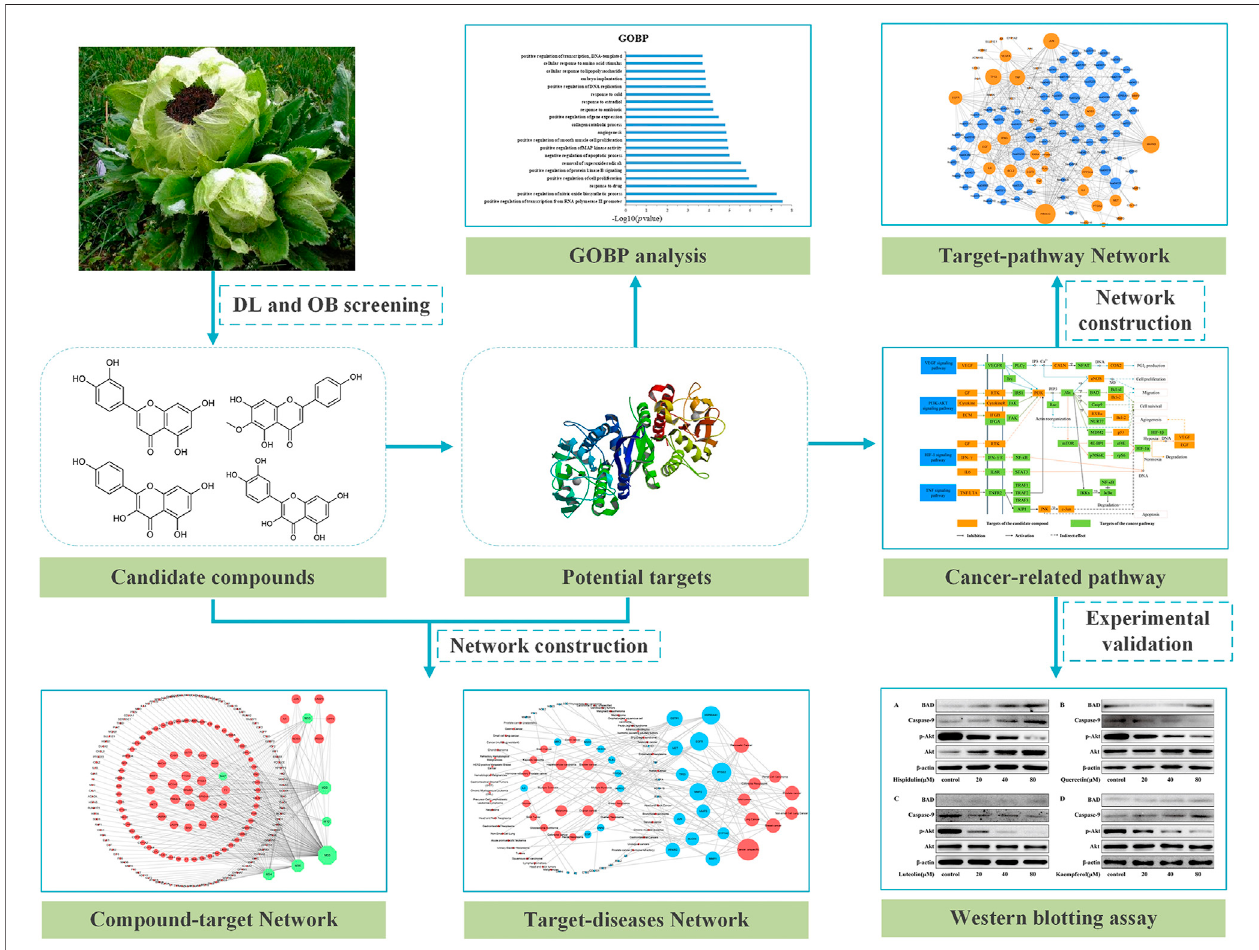
FIGURE 1 | Work fl ow of systems pharmacology to dissect the anti-tumor mechanism of Saussurea involucrata.